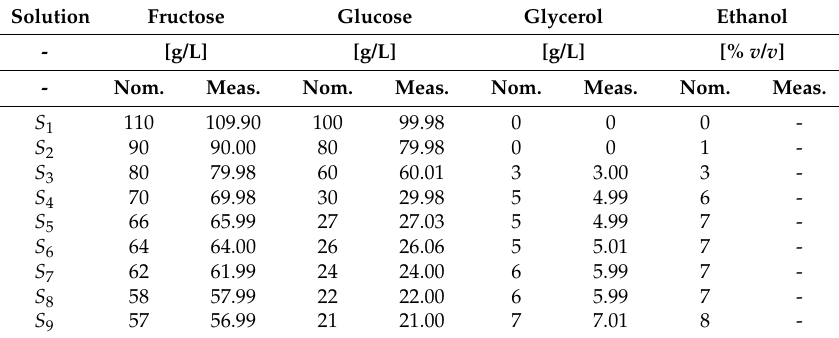
Table 3. Composition of the model solutions representing a stuck wine fermentation process from S 1 (raw grape must) up to S 9 (stuck fermented model solution) [30]. The measured values are obtained using a R200D microscale from Sartorius.